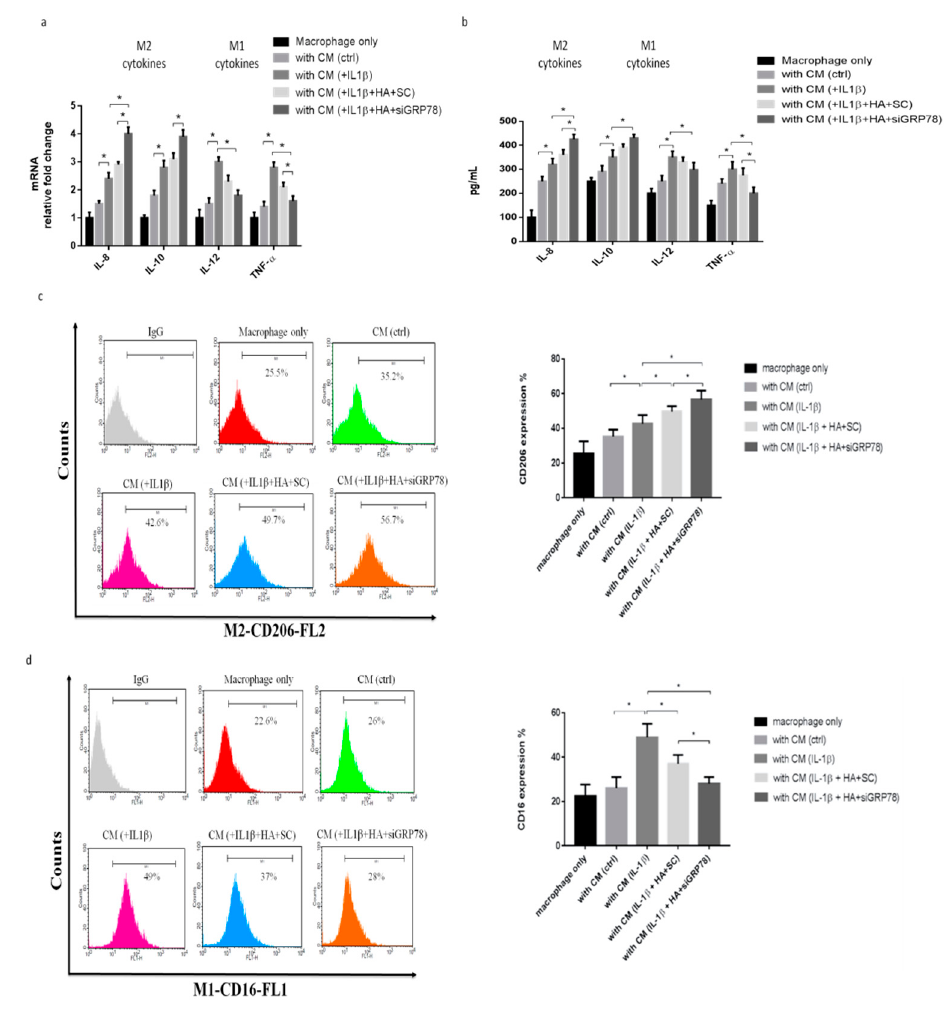
Figure 6. HMW-HA treatment in synoviocytes affected macrophage polarization toward the M2 phenotype. HMW-HA treated in knockdown GRP78 synoviocytes, and the supernatant was then collected from synoviocytes as CM and then used to treat THP-1. ( a ) Quantitative PCR analysis of IL-8, IL-10, IL-12, and TNF- α . ( b ) ELISA analysis of IL-8, IL-10, IL-12, and TNF- α . ( c , d ) Flow cytometry analysis of the expression of CD206, a marker of M2, and the expression of CD16, a marker of M1. Data are expressed as a mean ± SD, * p < 0.05. IgG as a negative control. The data presented are representative of three independent experiments.